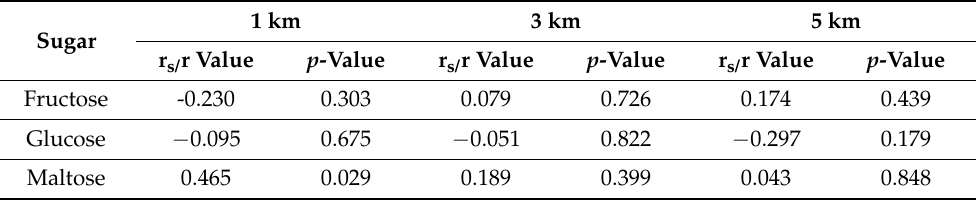
Table 2. Statistical analysis of the effect of rural-to-urban ratio of land use on composition of sugars found in honey collected by 22 colonies of Japanese honeybee in various locations within Kyushu, Japan, between June 2018 and August 2019. Statistical values for rural-to-urban ratios within radii of 1, 3 and 5 km were calculated. N for all statistics was 22. All maltose values were calculated using Pearson’s product-moment correlation (r) and all fructose and glucose values were calculated using Spearman’s rank correlation (r s ). 1 km 3 km 5 km Sugar r s/ r Value p -Value r s/ r Value p -Value r s/ r Value p -Value Fructose -0.230 0.303 0.079 0.726 0.174 0.439 Glucose − 0.095 0.675 − 0.051 0.822 − 0.297 0.179 Maltose 0.465 0.029 0.189 0.399 0.043